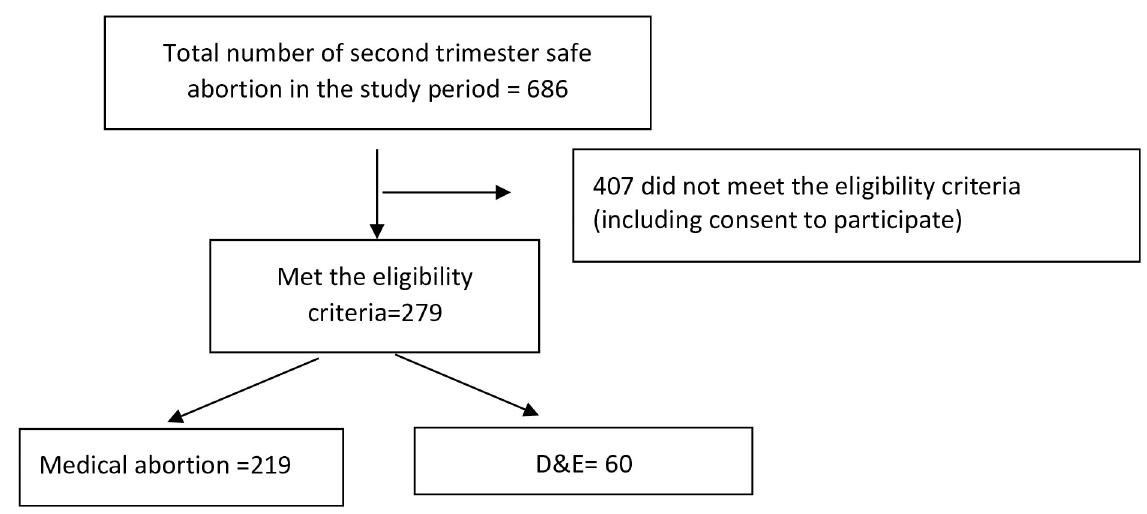
Fig 1. Flow chart of patient enrollment.